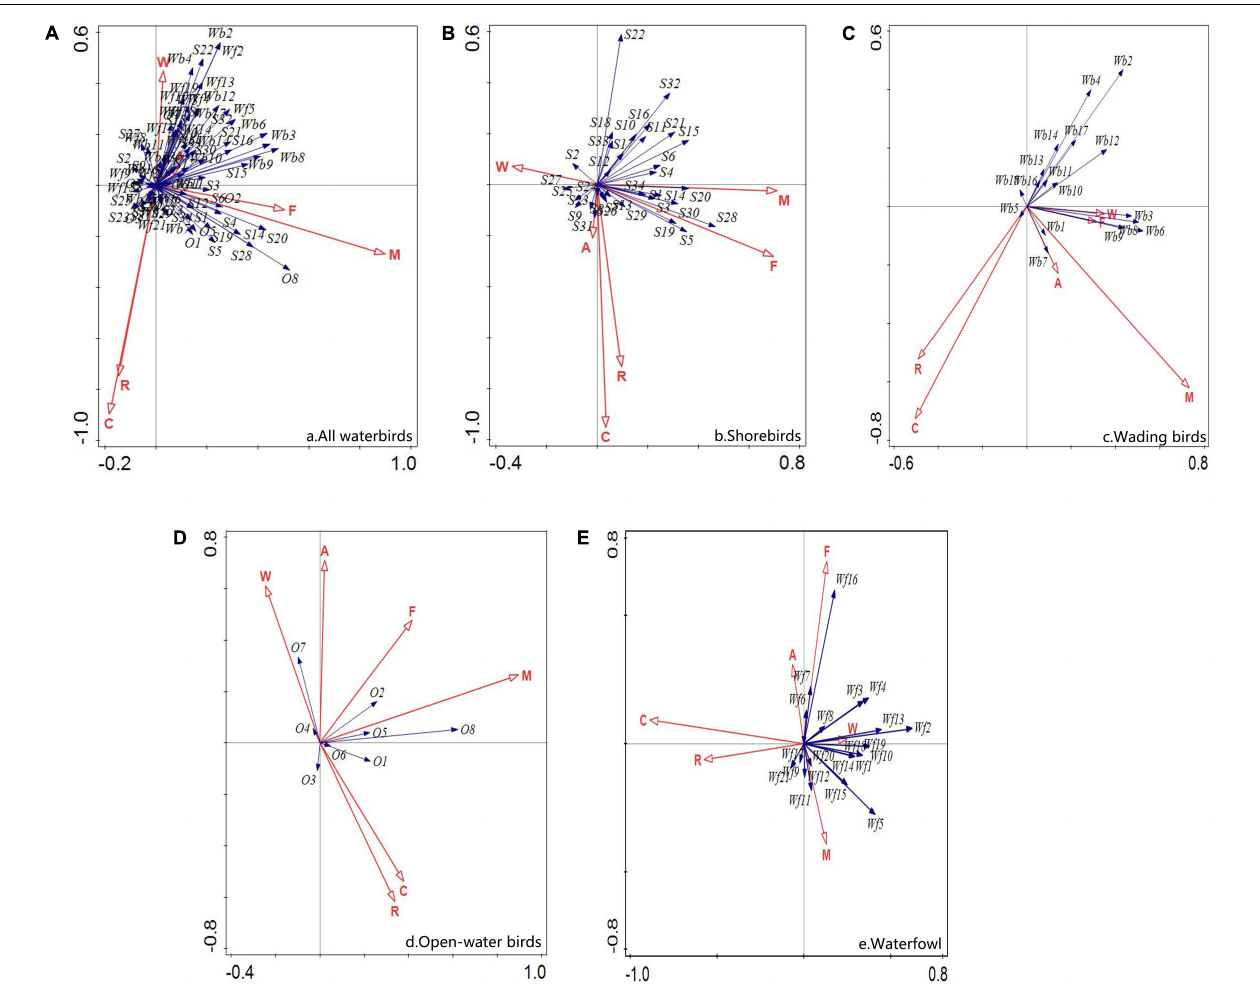
FIGURE 2 | RDA biplot of habitat variables and the abundances of waterbird. The red arrows indicate environment factors, the blue lines indicate species factors, and the length of each arrow indicates the strength of the relationship between an environmental factor and abundance. The angle of the arrow indicates the strength of the environmental factor. Explanatory variables: M, the area of mangroves (hm 2 ); F, the area of tidal flats (hm 2 ); W, the area of water bodies (hm 2 ), A, the area of aquaculture ponds (hm 2 ); R, road length (km); B, the area of built-up land (hm 2 ). (A) Biplot of habitat variables and the abundances of all waterbirds. (B) Biplot of habitat variables and the abundances of shorebirds. Shorebirds: S1- Pelecanus crispus , S2- Egretta sacra , S3- Pluvialis squatarola , S4- P. fulva , S5- Charadrius alexandrines , S6- C. dubius , S7- C. mongolus , S8- Numenius minutes , S9- N. phaeopus , S10- N. madagascariensis , S11- N. arquata , S12- Limosa limosa